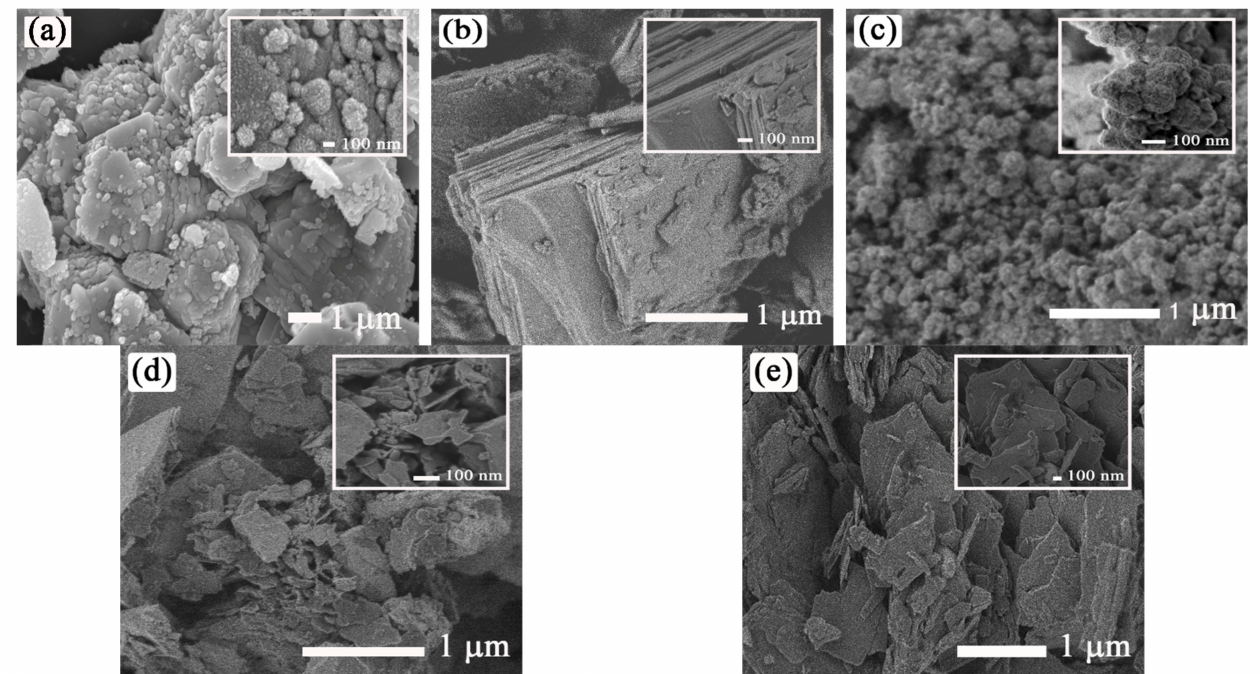
Figure 3. SEM images of ( a ) ZnO, ( b ) La-ZnO, ( c ) Ce-ZnO, ( d ) Pr-ZnO and ( e ) Nd-ZnO calcined to 500 ◦ C.